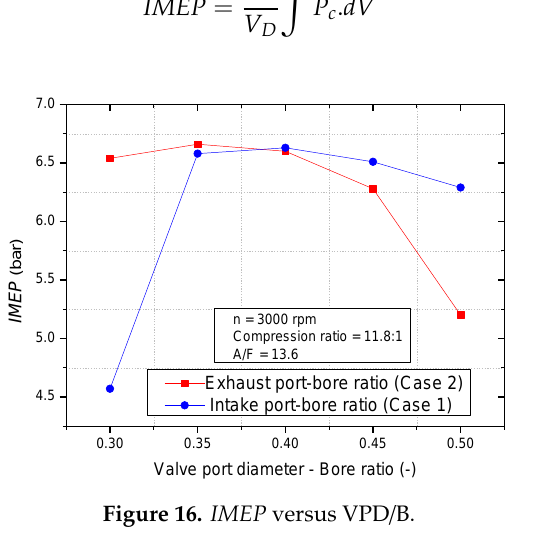
Figure 16. IMEP versus VPD / B.